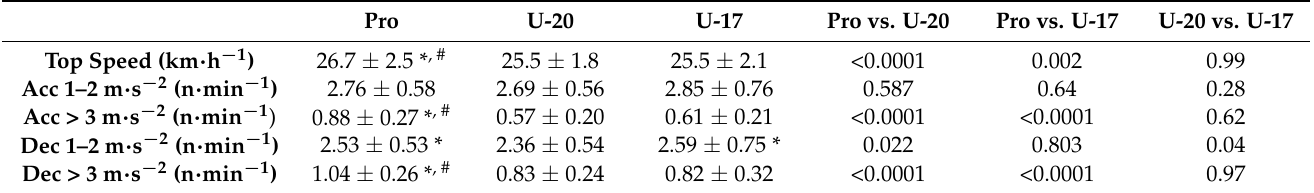
Table 1. Top speed and number of accelerations and decelerations for three age groups. Values are presented as mean ± sd.